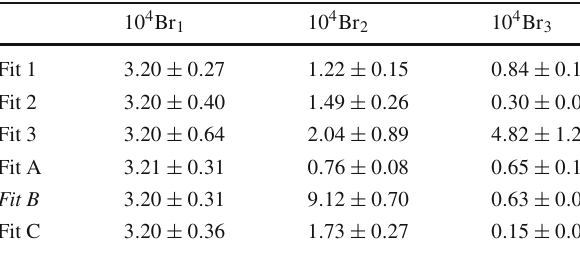
Table 4 The Br 1 , 2 , 3 denotes the branching ratios of (cid:3) 0 − , (cid:3) 0 − , respectively. The PDG [36] value → ¯ D (cid:4) → ¯ D ∗ (cid:4) (cid:3) 0 c K c K b b of the branching ratio of (cid:3) b → J /(cid:2) pK − is ( 3 . 2 ± 0 . 6 ) × 10 − 4